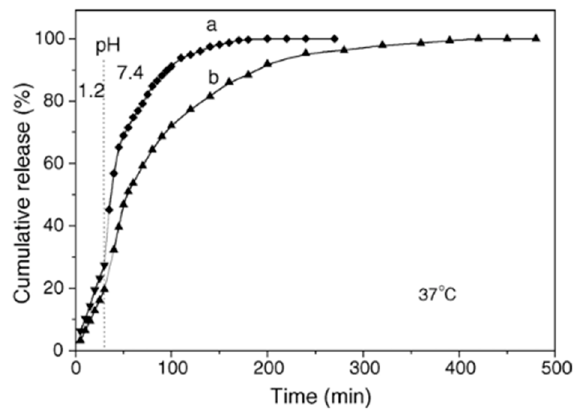
Figure 9. Release profiles of ( a ) IBU-loaded CaCO 3 crystals and ( b ) IBU-loaded (PRO/PSS) 5 -coated CaCO 3 crystals in simulated gastric fluid for the first 30 min, followed by simulated intestinal fluid for the remaining time, at 37 °C. Figure taken with permission from Reference [106], copyright© 2006, Elsevier.